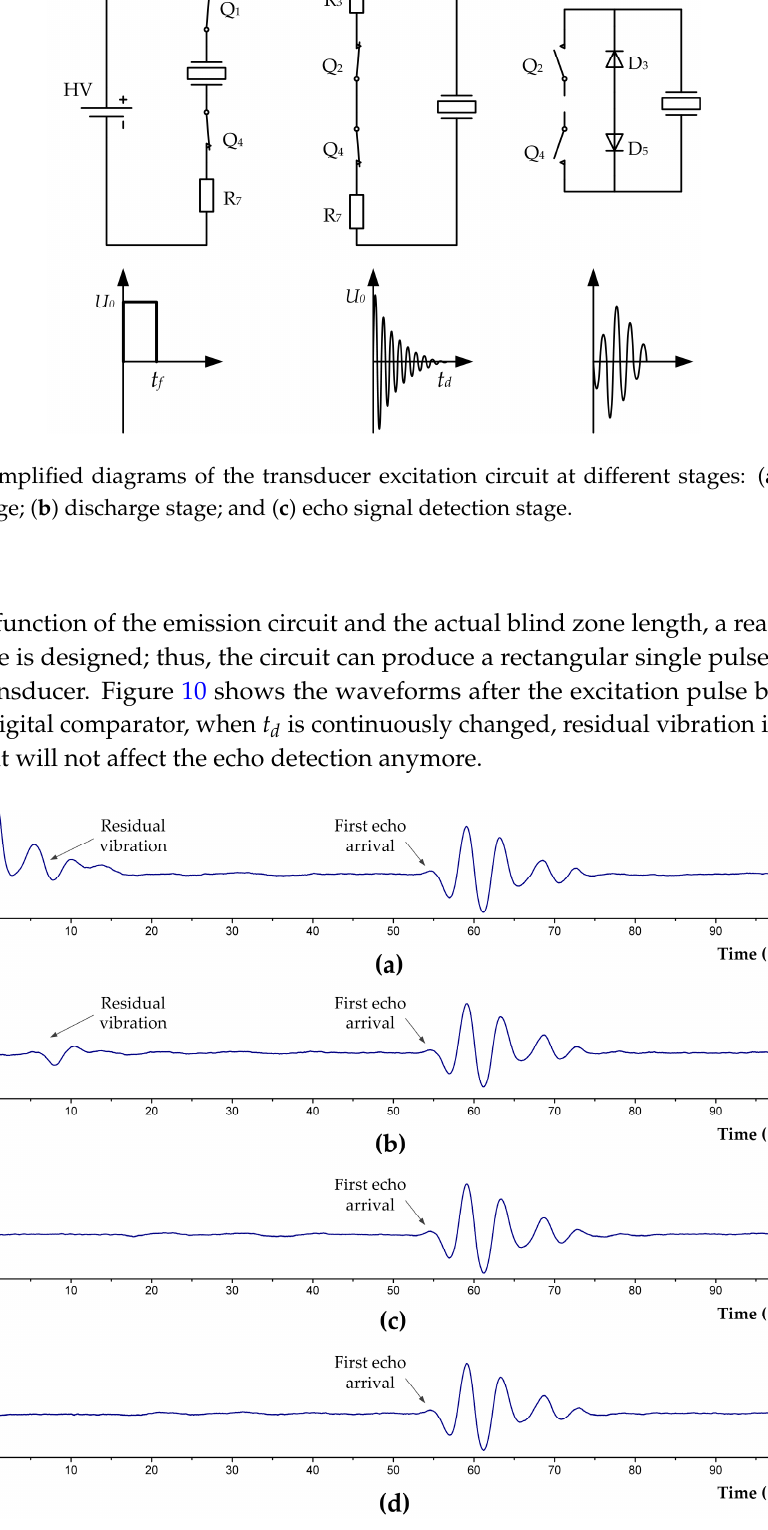
Figure 10. Test results of the acoustic emission circuit at different discharge duration t d . ( a ) t d = 0 µs; ( b ) t d = 5 µs; ( c ) t d = 10 µs; and ( d ) t d = 12 µs.